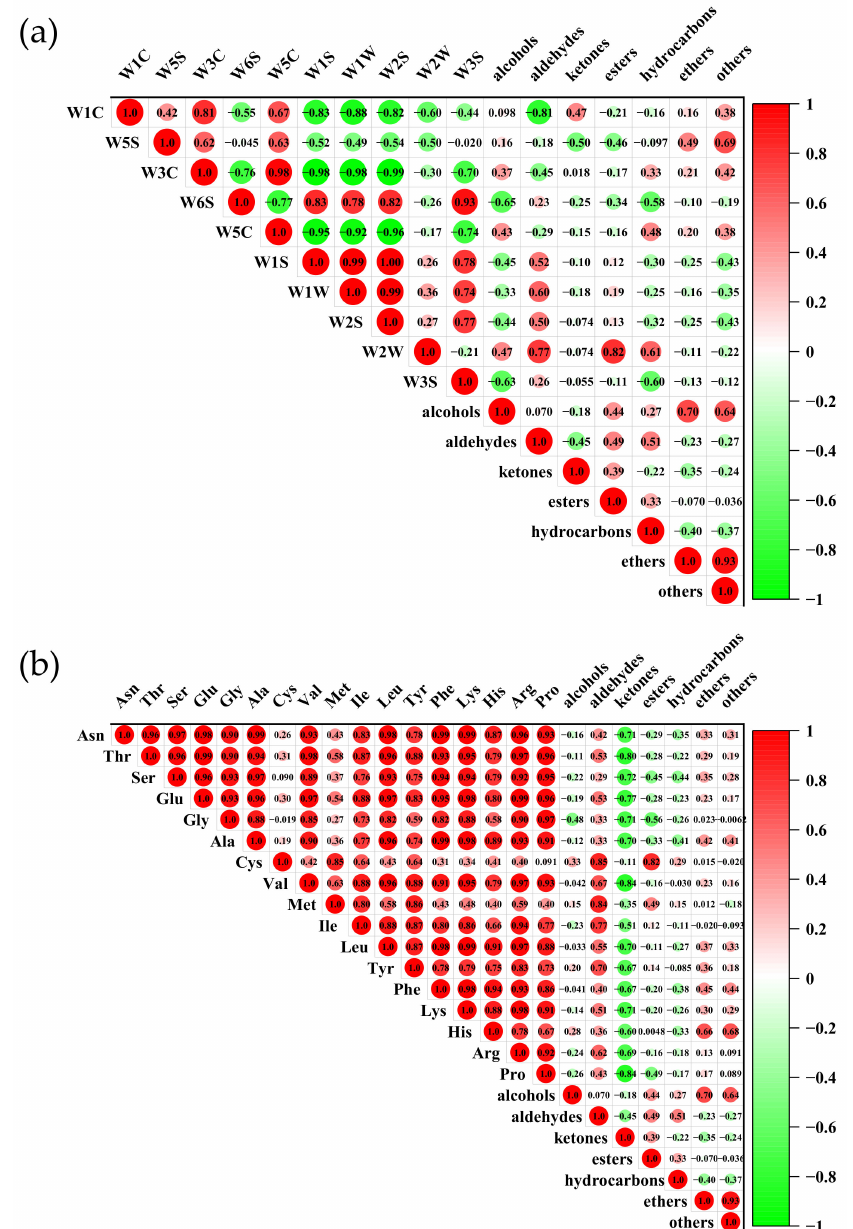
Figure 5. Correlations between ( a ) electronic nose and volatile flavor components and ( b ) free amino acids and volatile flavor